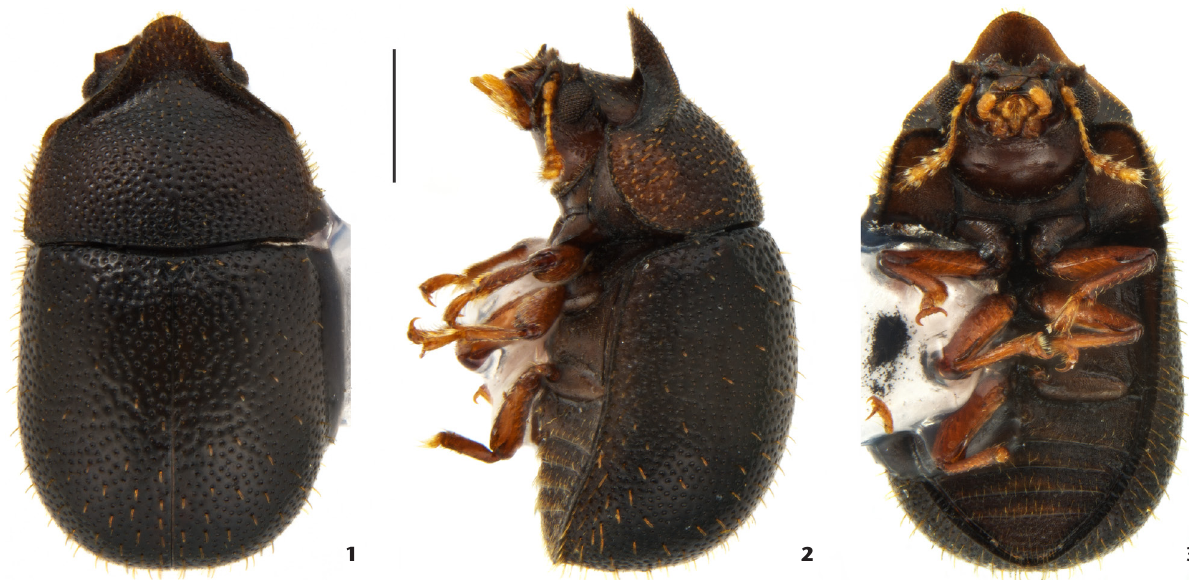
(Fig. 7) about four times as long as broad, subcylindrical, lateral margins parallel in the anterior two-thirds of their lengths, and apex subtriangular and